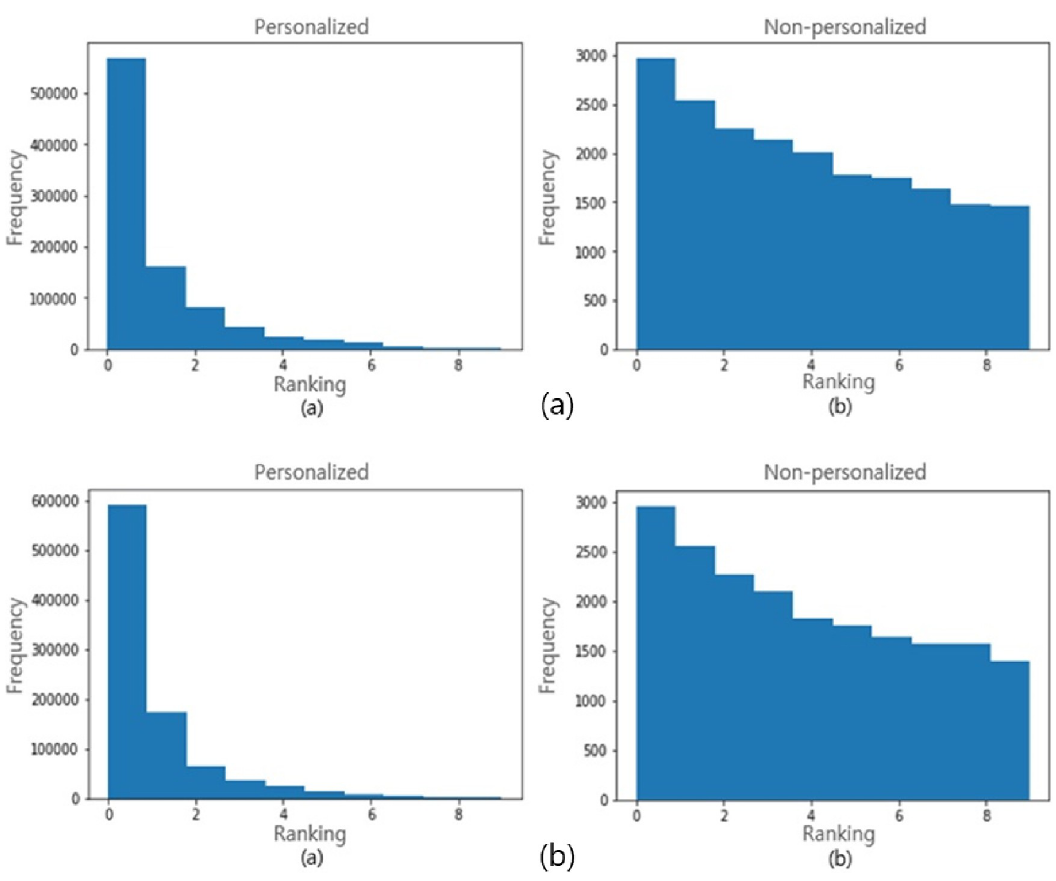
Fig 9. Ranking results for the target candidate for each embedding method with (a) Eq (10) and (b) Eq (11).